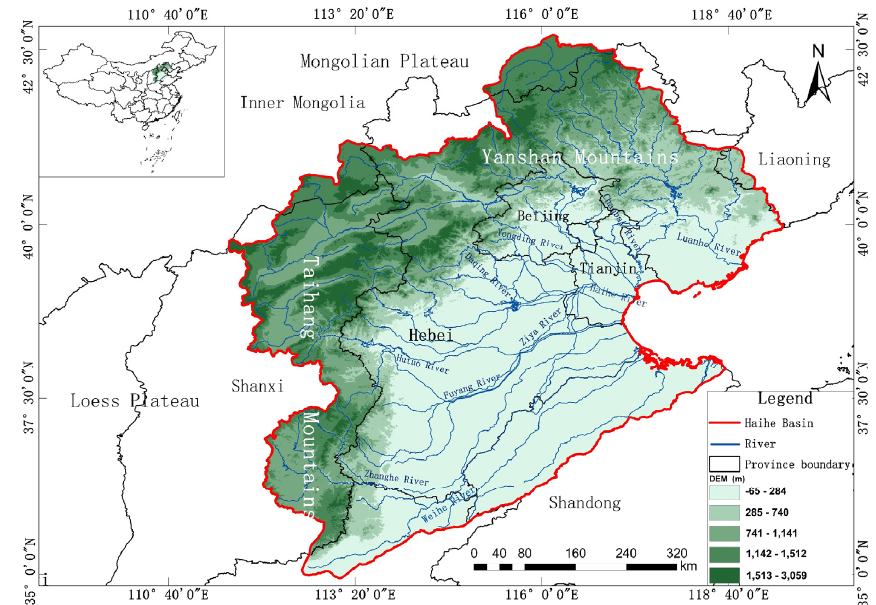
Figure 1. Geographical location and topographic map of the Haihe River Basin.